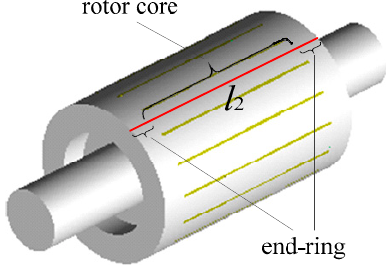
Figure 13. 3D model of the rotor.